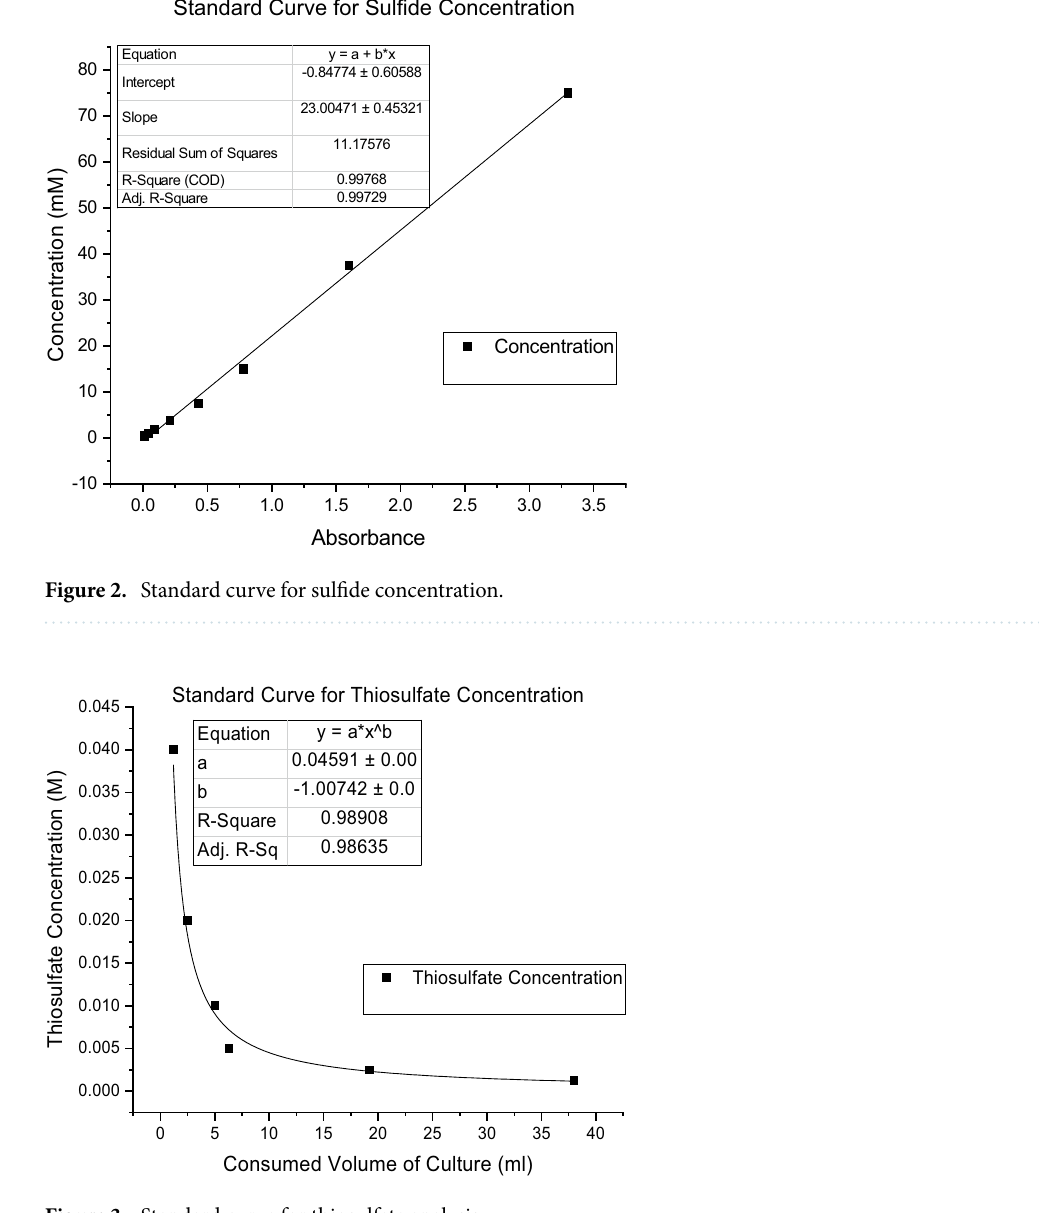
Figure 3. Standard curve for thiosulfate